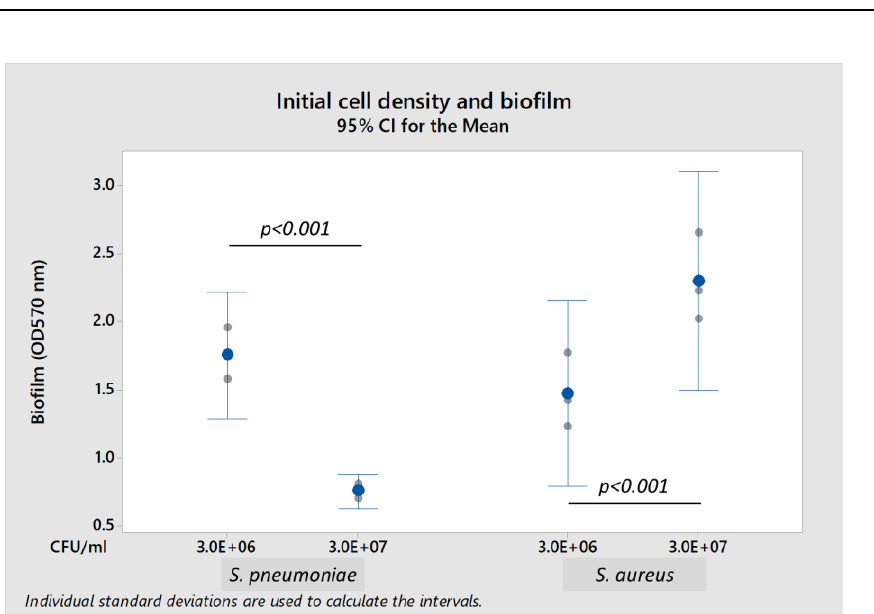
Figure 1. Effect of initial bacterial cell density on biofilm production by S. pneumoniae 19F and S. aureus A10 strains using the crystal violet assay. Each result was derived from three independent experiments or biological replicates (with each assay performed as technical triplicates). Each small gray datapoint represents the average or mean of technical triplicates, while each blue datapoint depicts the mean of three independent experiments. Intervals represent 95% confidence interval (CI) for the mean. p -value < 0.05 was considered statistically significant by the independent samples Mann-Whitney U test.